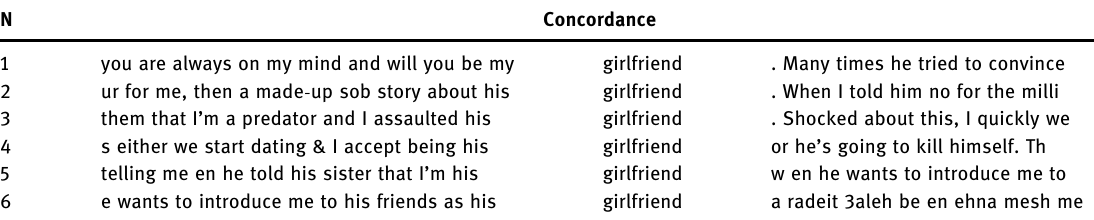
Table 23: Concordance lines for girlfriend